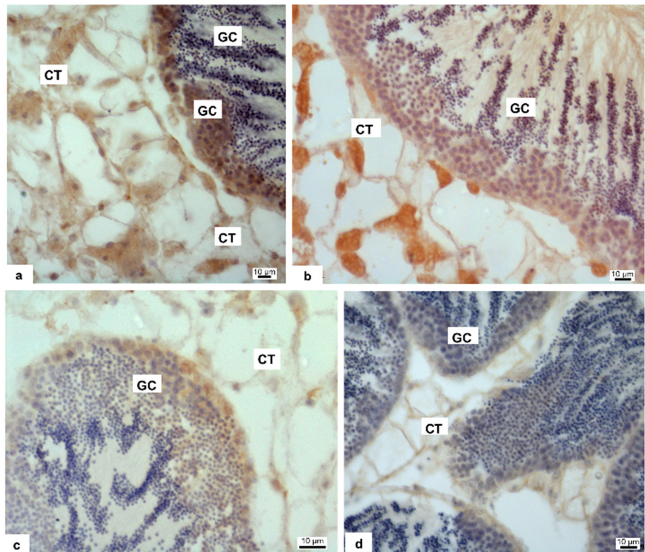
Figure 3. Immunolabeling of M. galloprovincialis male gonad with anti-3 β -HSD antibody. Brown coloration indicates the enzyme presence. Nonexposed ( a ) and exposed mussels to 1 ( b ), 10 ( c ) and 100 pM ( d ) HgCl 2 , respectively. Germ cells (GC) are positive to antibody in control and 1 and 10 pM treated samples ( a – c ); the positivity disappears almost completely in 100 pM treated samples ( d ) In